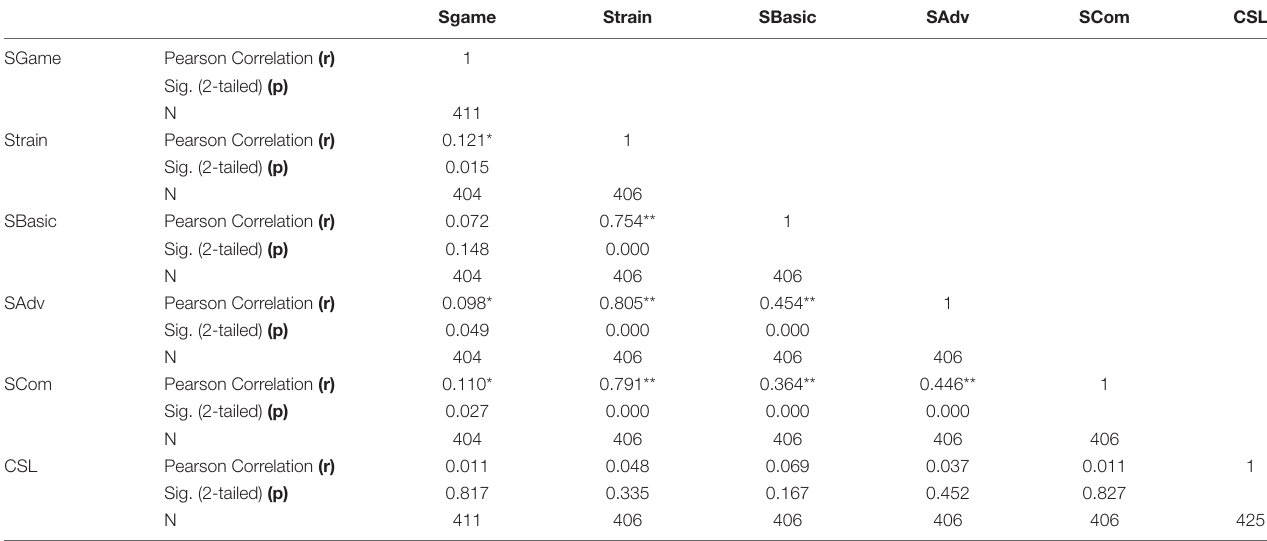
TABLE 3 | Pearson correlations among competition scores and CSL. Sgame Strain SBasic SAdv SCom CSL